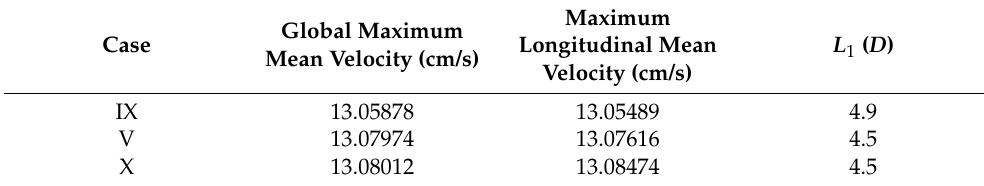
Figure 4. The simulation results of case V, case VIII, and case X are compared with those of Zong and Nepf [3]. The data in the figure is the centerline ( y = 0) longitudinal mean velocity ( u ) distribution. The gray part indicates the internal area of vegetation patches. Table 4. Some results of cases V, IX, and X for time step independence validation, where L 1 is defined in Section 3.